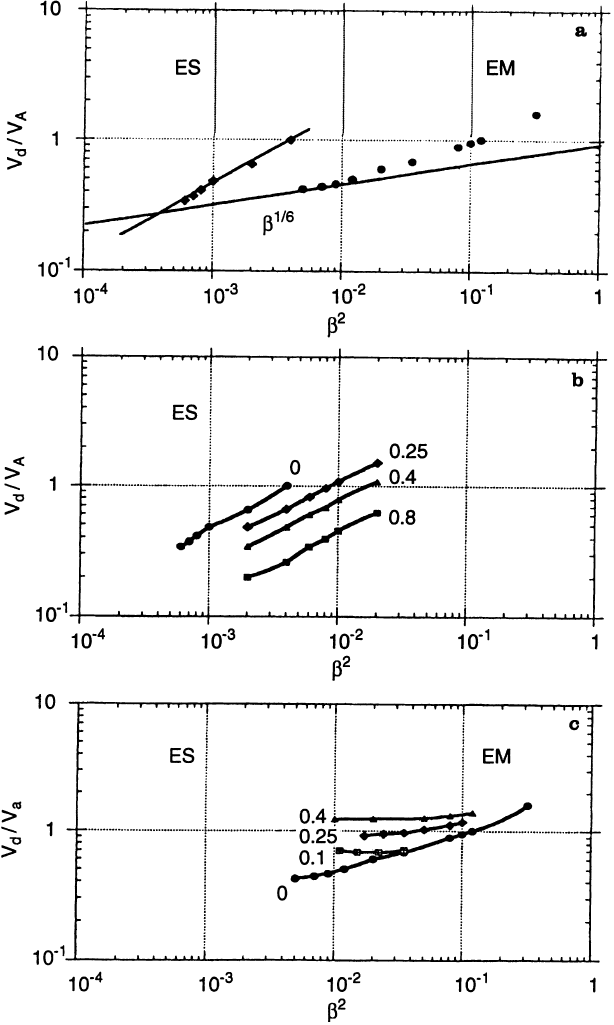
Fig. 7. Same as Fig. 6 with an extended time-scale. The electric components exhibit higher frequencies than the magnetic ones. A strong peak of short duration, at 21:40:35 UT, stands out from the other fluctuations on the magnetic component